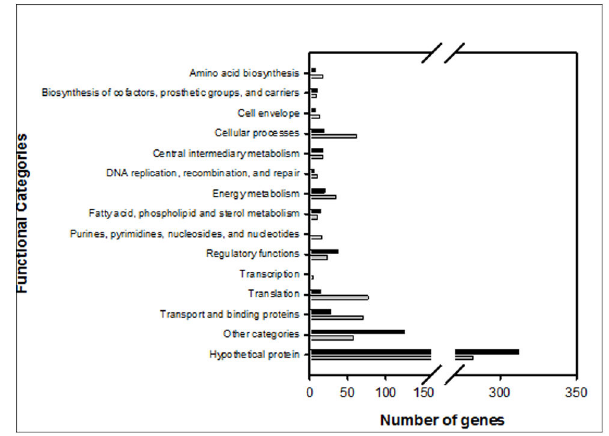
Figure 3. Functional classification of the genes differentially expressed after IAA treatment.